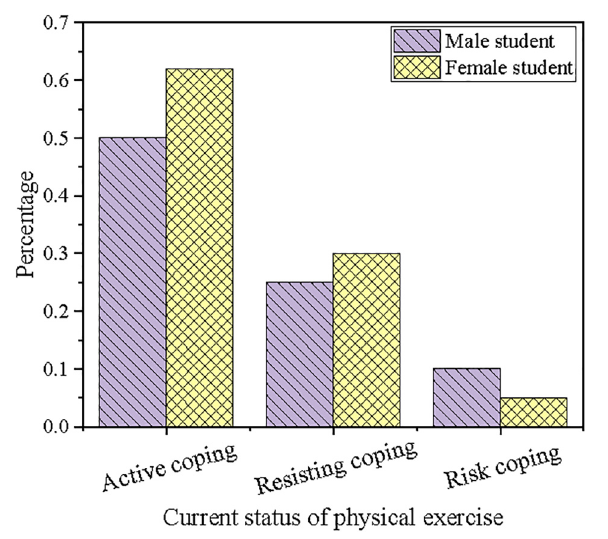
FIGURE 3 | Comparison on coping attitude to physical exercise of students in different genders.